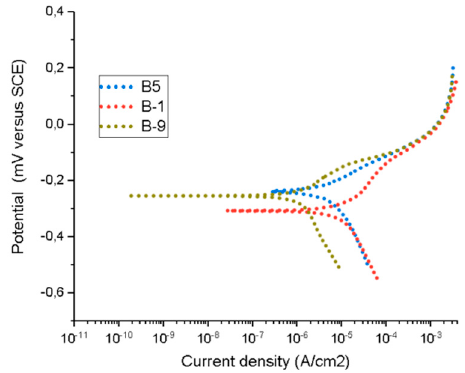
Figure 8. Potentio-dynamic polarization curves of coatings deposited under different pressure conditions of oxygen and acetylene.